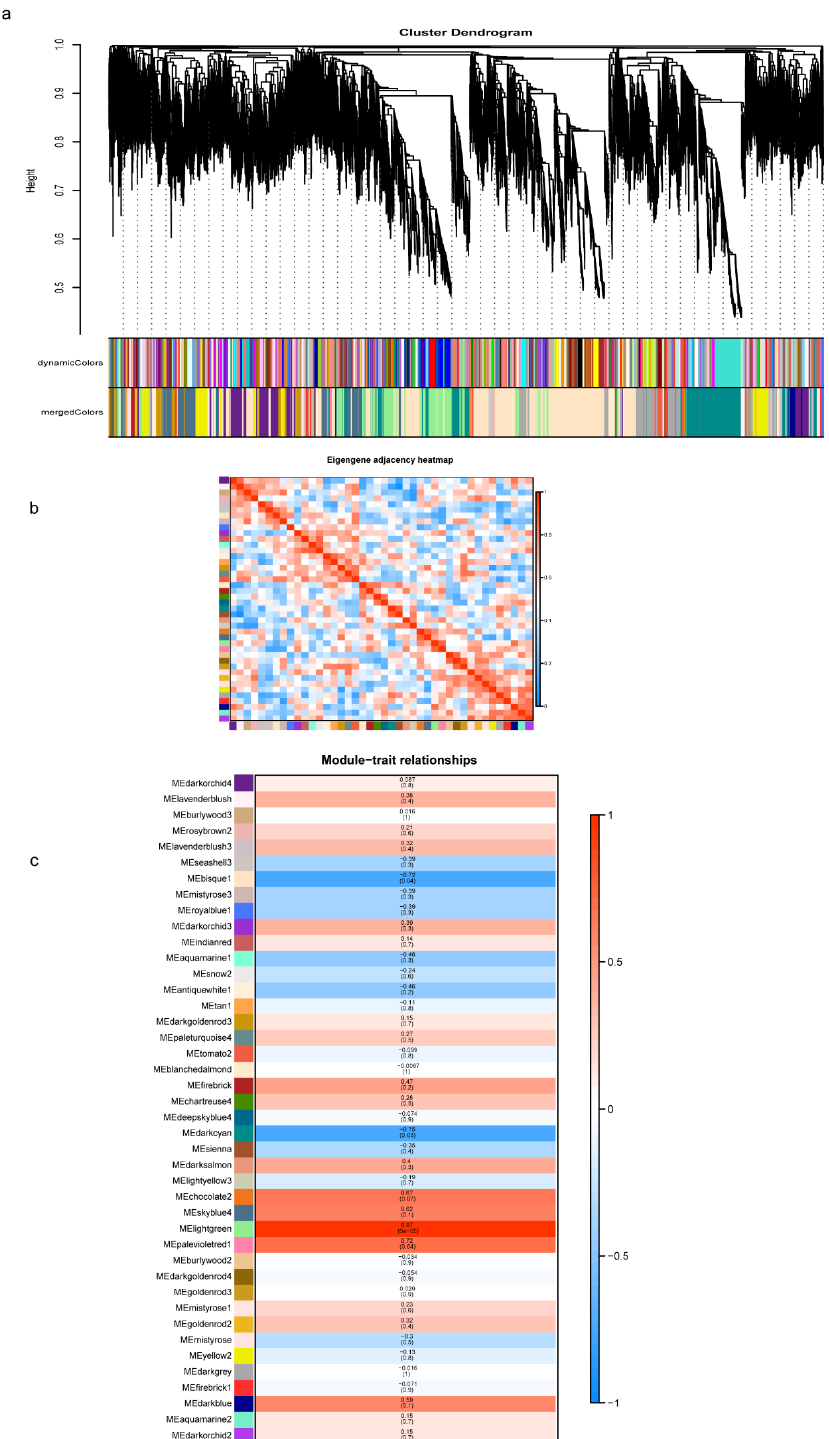
Figure 5. Weighted gene co-expression network analysis. ( a ) Hierarchical cluster tree showing co-expression modules identified using WGCNA; ‘DynamicColors” represents modules divided according to clustering results, and “MergedColors” represents the merging of the module with a similar expression pattern according to the module similarity, with the analysis conducted according to the merged module. ( b ) Module gene correlation analysis; each row and column represent a gene; the darker the color of each point indicates a higher connectivity between the two genes. ( c ) Sample expression pattern